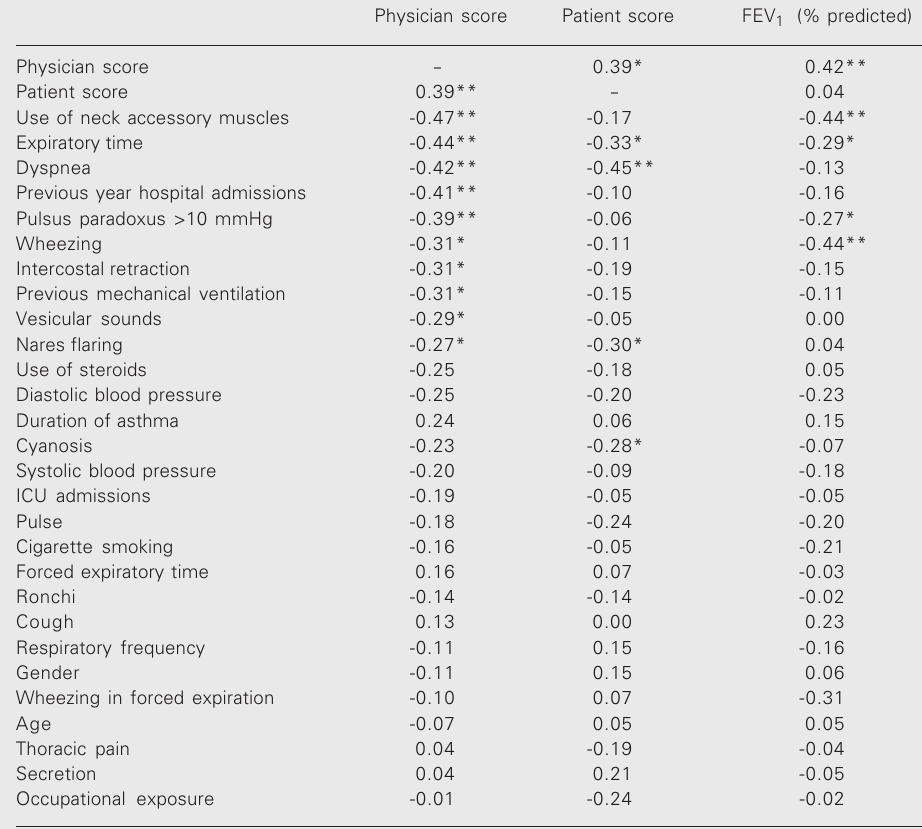
Table 1. Correlation coefficients between physician score, patient score, forced expiratory volume at the first second (FEV 1 ), and clinical